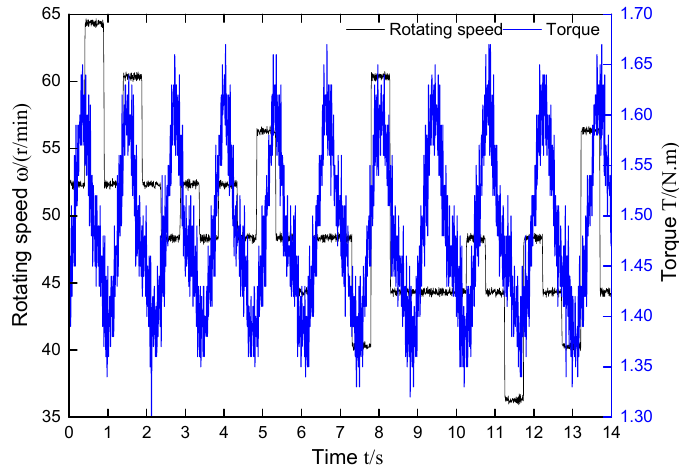
Figure 12. The change process of torque and rotating speed in Case 3. Figure 13 shows the average torque and rotational speed as a function of wave height with T = 1.26 s. The average torque and rotational speed increase with the increase of wave height, of which the change of average torque is insignificant and the change of average rotor is significant. The rotating speed and torque shift with the periodicity of the wave. The experimental results show that the physical model, which is designed according to the water oscillation mathematical model, can operate under regular wave conditions. When the experiment cycle stays the same, the average torque and rotational speed increase with the increase of wave height, of which the change of average torque is insignificant and the change of average rotational speed is significant.